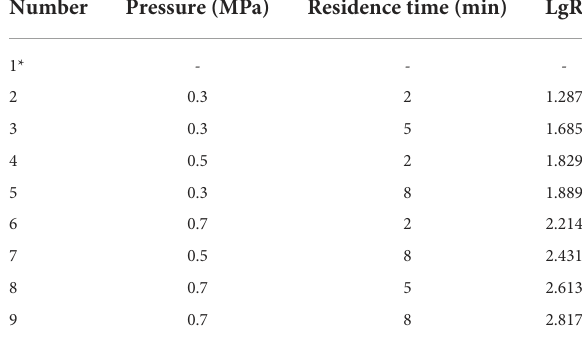
TABLE 1 Experimental condition of steam explosion and the corresponding severity